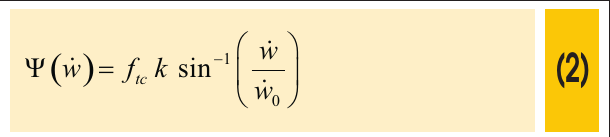
Figure 3 – Example of cohesive curve and its properties